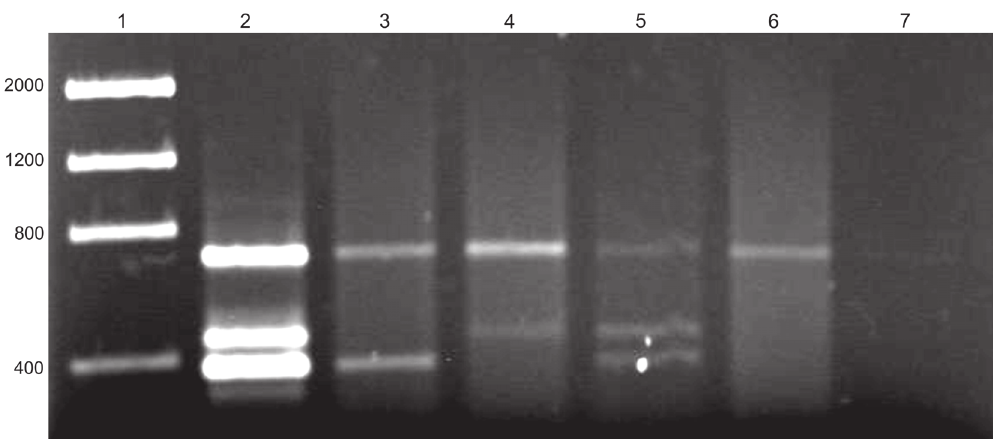
Figure 3. Sensitivity and specificity test of the Multiplex PCR protocol for detection and identification of species of Crassostrea native to the Brazilian coast. DNA-equivalent of a single larva (28.5 ng) was mixed with total extract of 1000-L-sample of plankton in different combinations: Lane 1. 1 kb Ladder. Lane 2: positive control lane (2 ng of adult specimens of each target species). Lane 3: DNA- equivalent of a single larva of C. brasiliana + total zooplankton DNA. Lane 4. DNA-equivalent of a single larva of C. rhizophorae + total plankton DNA Lane 5. DNA-equivalent of a single larva of C. brasiliana + C. rhizophorae + total plankton DNA. Lane 6. Total plankton DNA extract. Lane 7. Negative control.